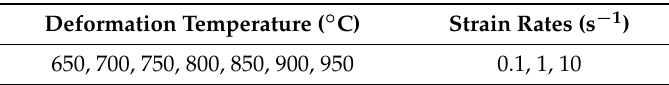
Table 2. Test matrix of the hot tensile